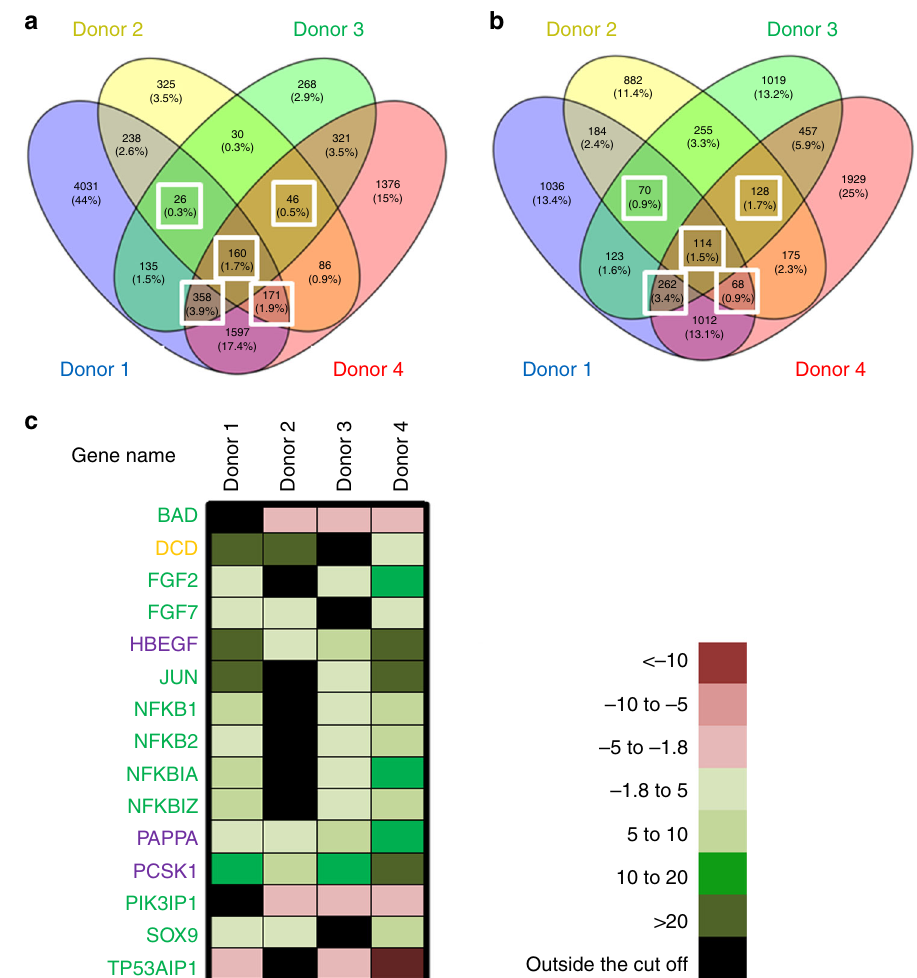
Fig. 6 Microarray-based analysis of genes related to anagen-prolonging pathways after stimulation with Sandalore ® (500 µ M). a , b Venny diagrams 65 show the upregulated and downregulated genes (cut-off: fold change > − 1.8 or > + 1.8 and equidirectional changes). White squares indicate genes upregulated and downregulated in at least three of four donors (independent experiments). The heatmap shows the list and the expression level of the most upregulated and downregulated genes related to the different pathways regulated after OR2AT4 activation (cut-off: fold change > − 1.8 or > + 1.8 and equidirectional changes) in at least three of four donors (independent experiments) ( c ). Green: apoptosis related, orange: dermcidin related, and violet: IGF